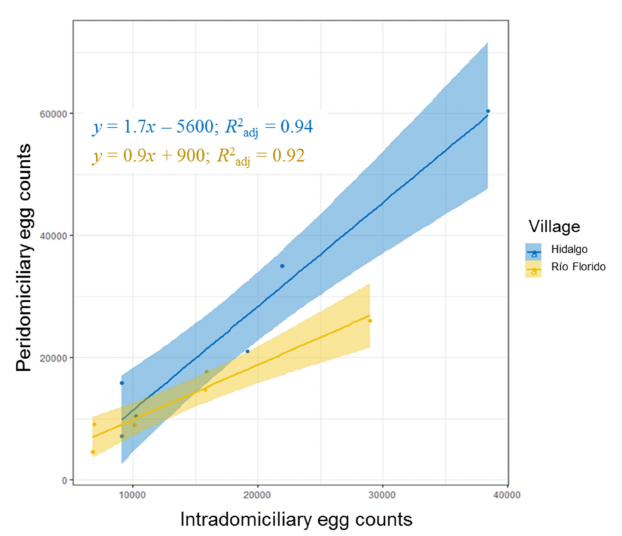
Figure 6. Correlations between seasonal eggs counts obtained from intradomiciliary and peridomicil- iary ovitraps placed in Hidalgo and R í o Florido over the three-year study. Shaded regions around fitted lines indicates the 95% confidence interval of each